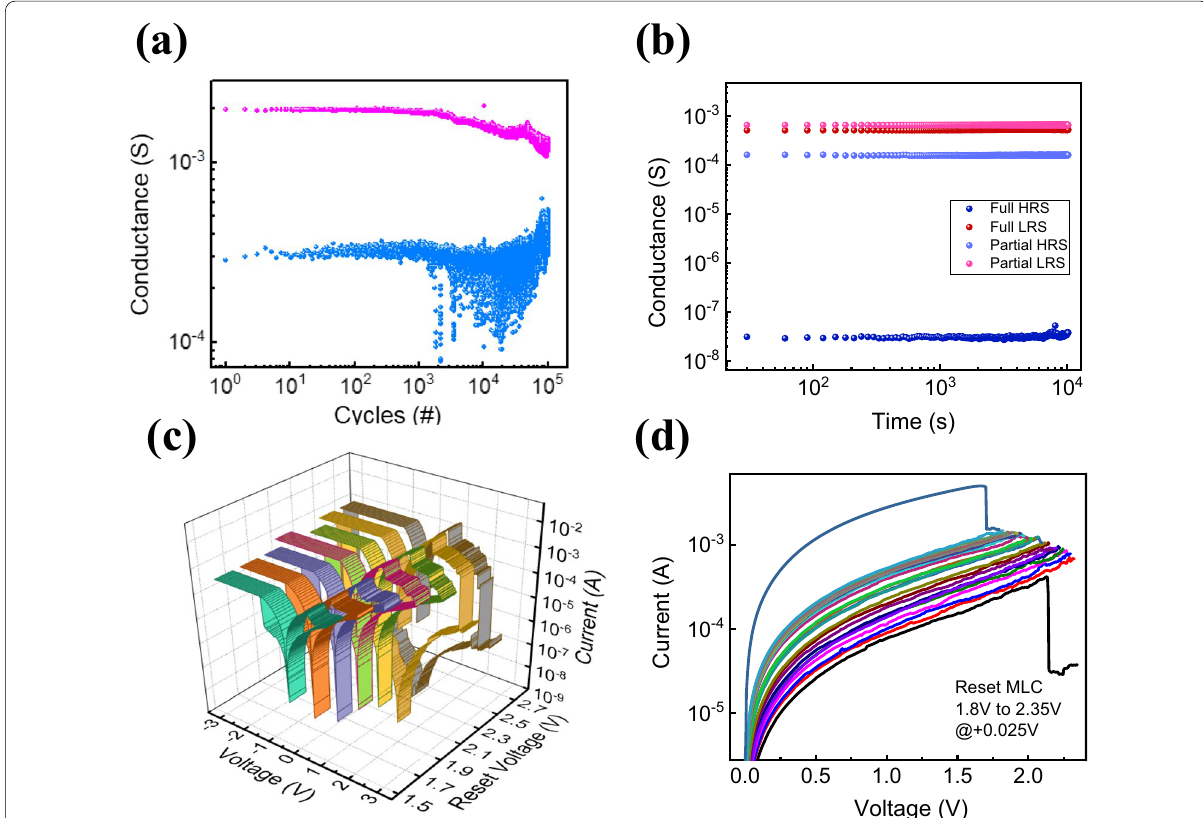
Fig. 4 a Endurance characteristic of the device for 10 5 cycles and b each deep and partial HRS and LRS retention characteristics for 10 4 s. MLC characteristics of c different reset voltages, d consecutive incremental voltage